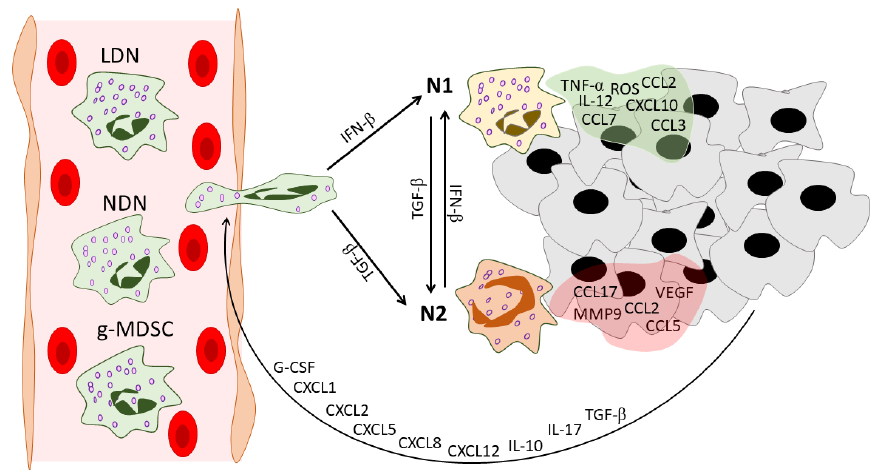
Figure 1. Neutrophil heterogeneity during tumor development. In the peripheral blood of cancer patients, three distinct populations of circulating neutrophils can be found: NDNs, LDNs, and g- MDSCs. Tumors recruit neutrophils via various mediators. These mediators include G-CSF [19], CXCL1 [20], CXCL2 [21], CXCL5 [22], CXCL8 [23], CXCL12 [24], IL-10 [19], IL-17 [25], and TGF- β [26]. After infiltration into the tumor microenvironment, neutrophils gain an N1 or N2 phenotype under the action of IFN- β [27] or TGF- β [14], respectively. Neutrophils in their turn reshape the tu-